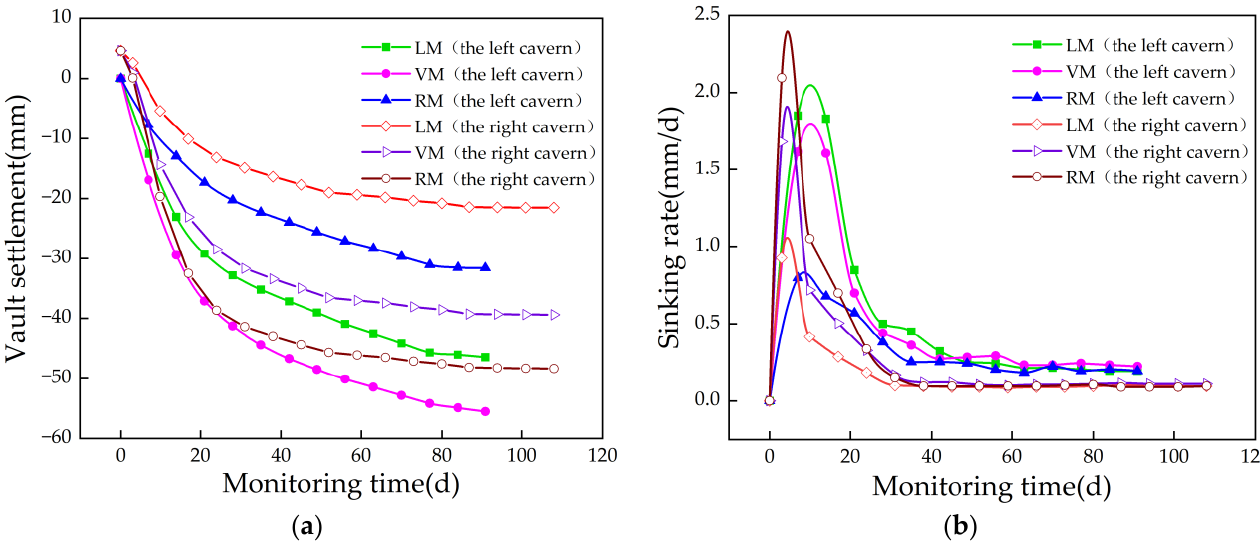
Figure 6. Development of the settlement and sinking rate of the vault. ( a ) Vault settlement; ( b ) the sinking rate of vault settlement